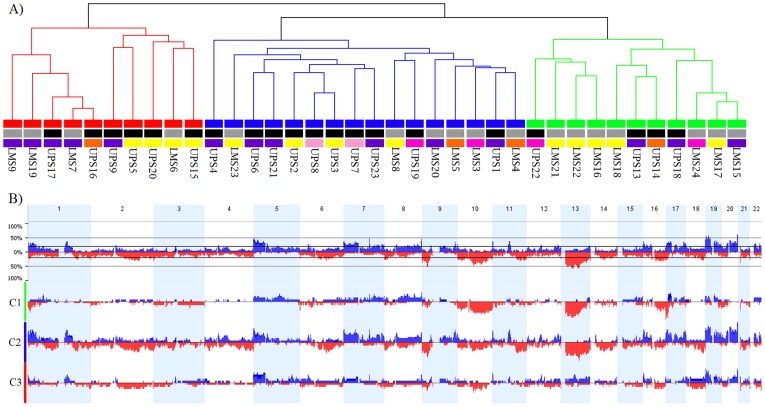
Unsupervised hierarchical clustering of 20 undifferentiated pleomorphic sarcomas (UPSs) and 17 leiomyosarcomas (LMSs).(A) In the dendrogram, cluster 1 is shown in green, cluster 2 is shown in blue, and cluster 3 is shown in red. Clusters related to the sites of anatomical origin were not observed for these tumors; origin sites include the following regions: upper extremity (pink), lower extremity (purple), trunk (orange), retroperitoneum (yellow), and head and neck (rose). (B) Genomic alterations were detected in clusters 1 (C1; 11 cases), 2 (C2; 16 cases), and 3 (C3; 10 cases). The top bars (blue) indicate genetic gains, whereas the lower bars (red) indicate genetic losses. The images shown were adapted from the output of the Nexus 6.0 software program.